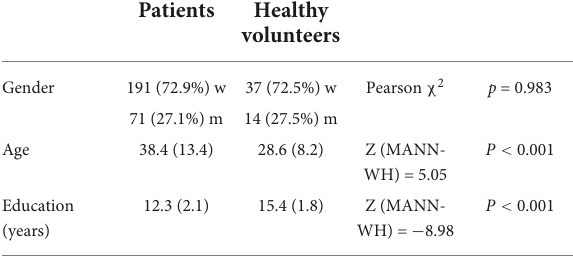
TABLE 1 Demographic variables of patients and healthy volunteers for Parental Bonding Inventory